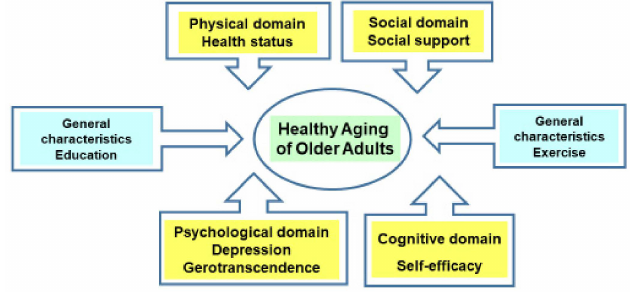
Figure 1. Factors affecting healthy